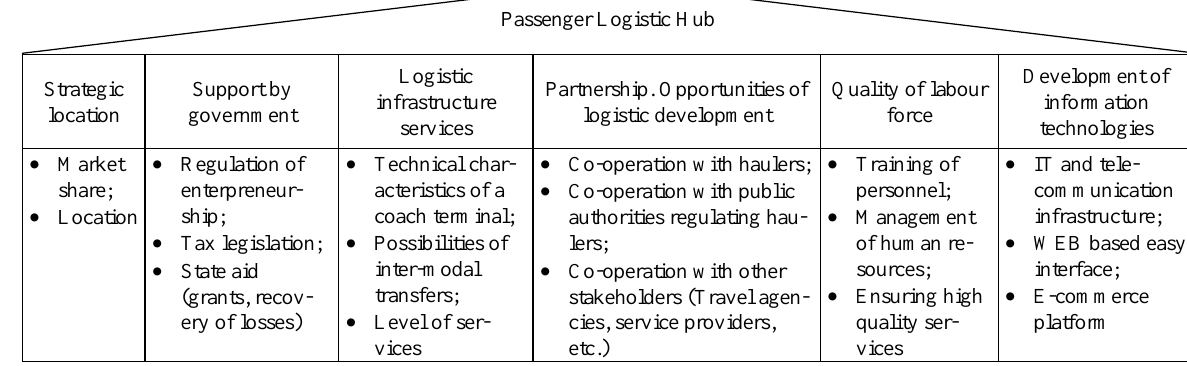
Fig 1. Critical factors for Logistics Hub Table 1. International routes to foreign countries and cities from Riga International Coach Terminal (2006) Country Cities